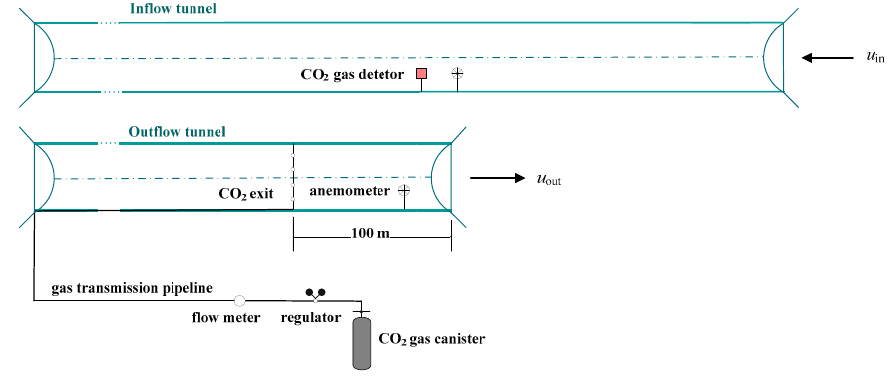
Figure 15. The locations of measuring points.